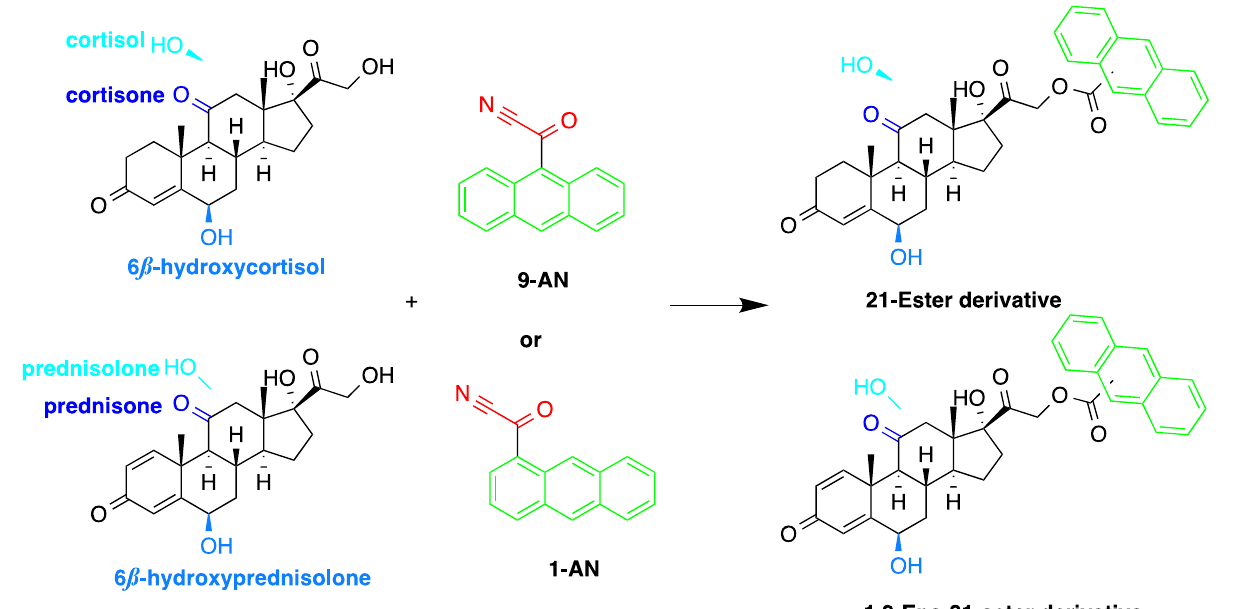
Figure 5. Esterification of primary alcohol functionality of cortisol and cortisone by 9-anthroyl nitrile (9-AN) or 1-anthroyl nitrile (1-AN).